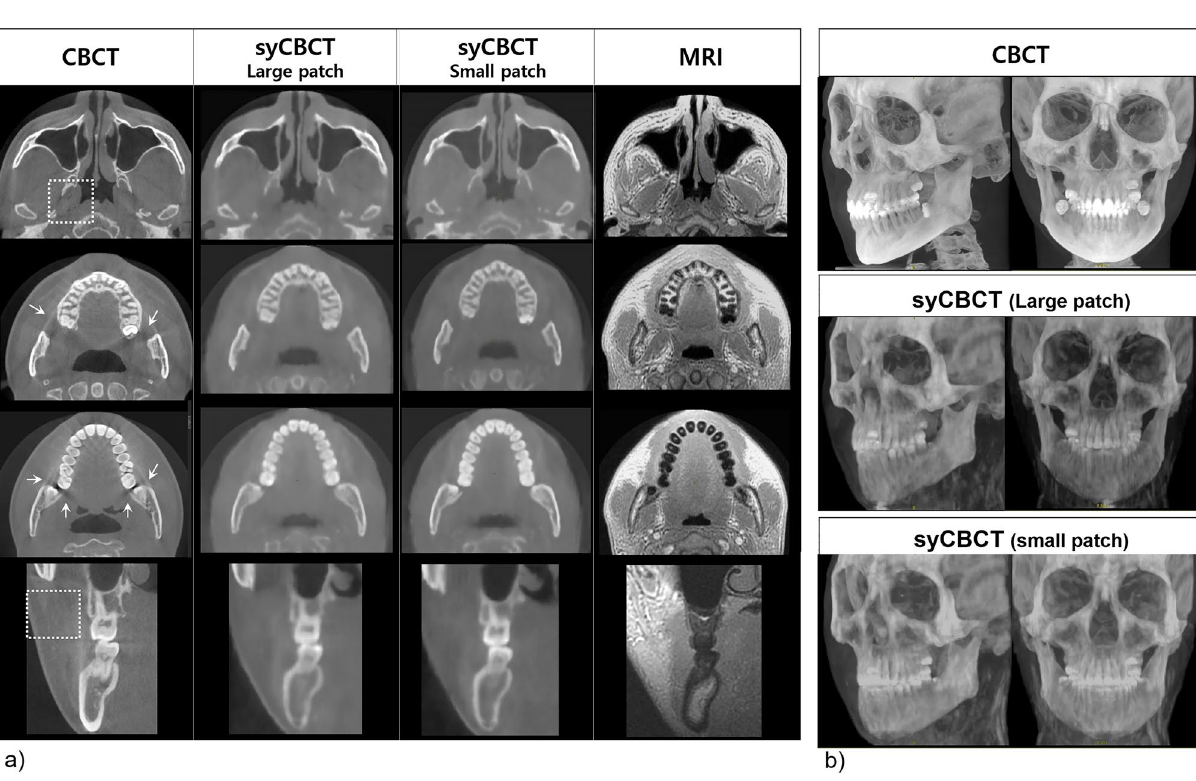
Figure 5. ( a ) The axial and cross-sectional images show the soft tissue of syCBCT with less noise, whereas more heterogeneity is observed in CBCT (dotted box). The scattering artifact (arrow) in the CBCT image is not evident in the syCBCT image. The margin of tooth structure is blurred in syCBCT. ( b ) Three-dimensional reconstruction of CBCT and syCBCT using the maximum intensity projection method. CBCT, cone-beam computed tomography; syCBCT, synthetic